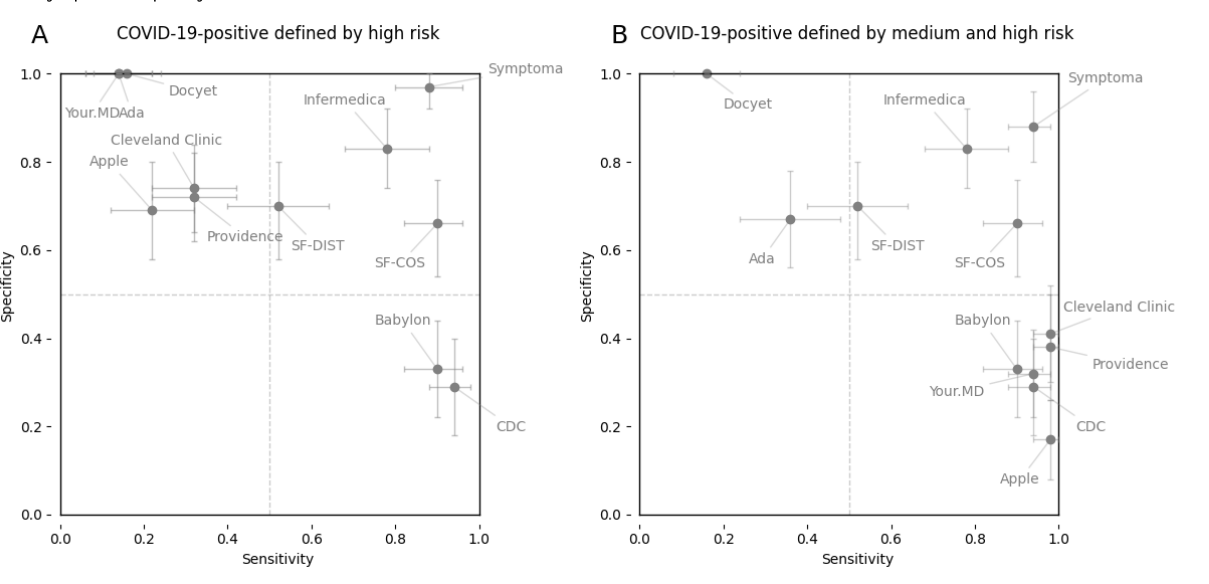
Figure 1. Sensitivities and specificities of web-based COVID-19 symptom checkers to COVID-19 cases and controls. The means of the 3000 random samples and 90% bootstrap CIs are reported as dots and crosses, respectively. (A) High risk: A COVID-19–positive prediction is defined only by a high risk result returned by a symptom checker. (B) Medium-high risk: A COVID-19–positive prediction is defined by either a medium risk or high risk result returned by a symptom checker. CDC: US Centers for Disease Control and Prevention; SF-COS: symptom frequency based on cosine similarity; SF-DIST: symptom frequency based on vector